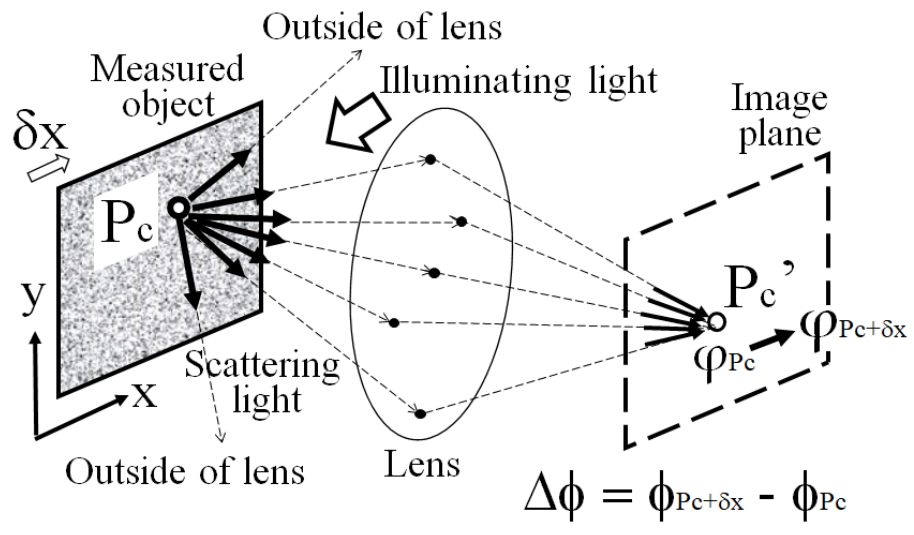
Figure 11. Model of measurement